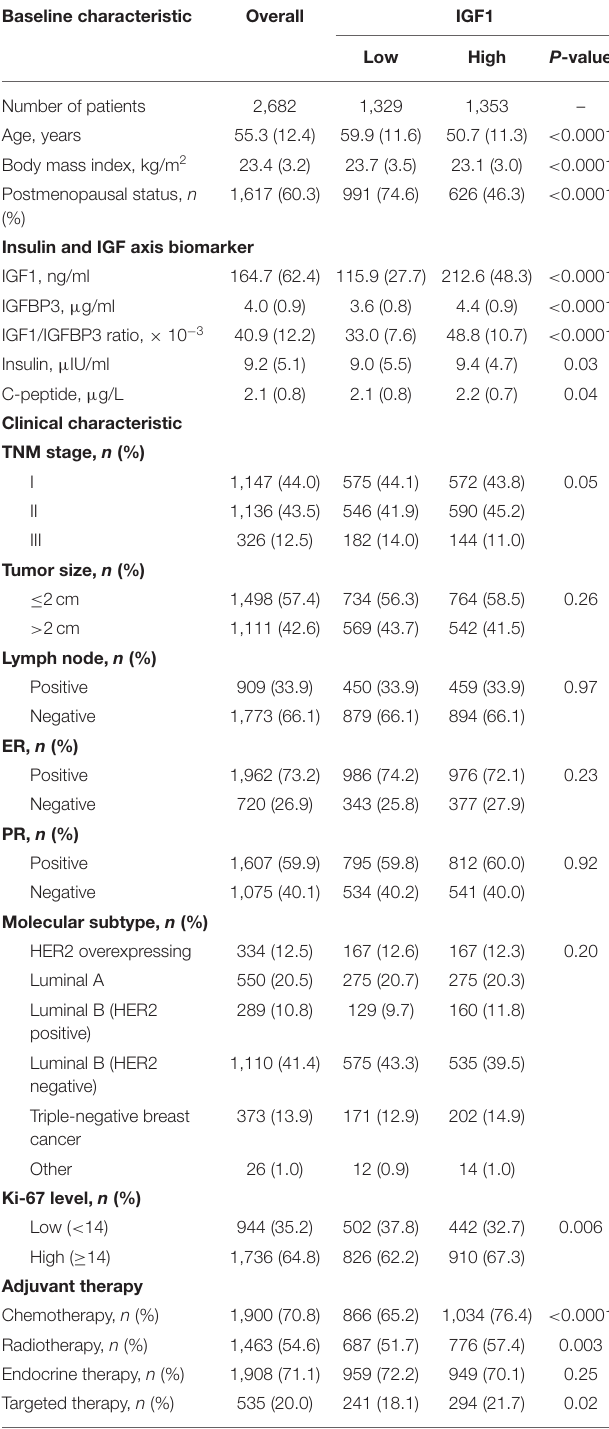
TABLE 1 | Baseline characteristics of study patients a